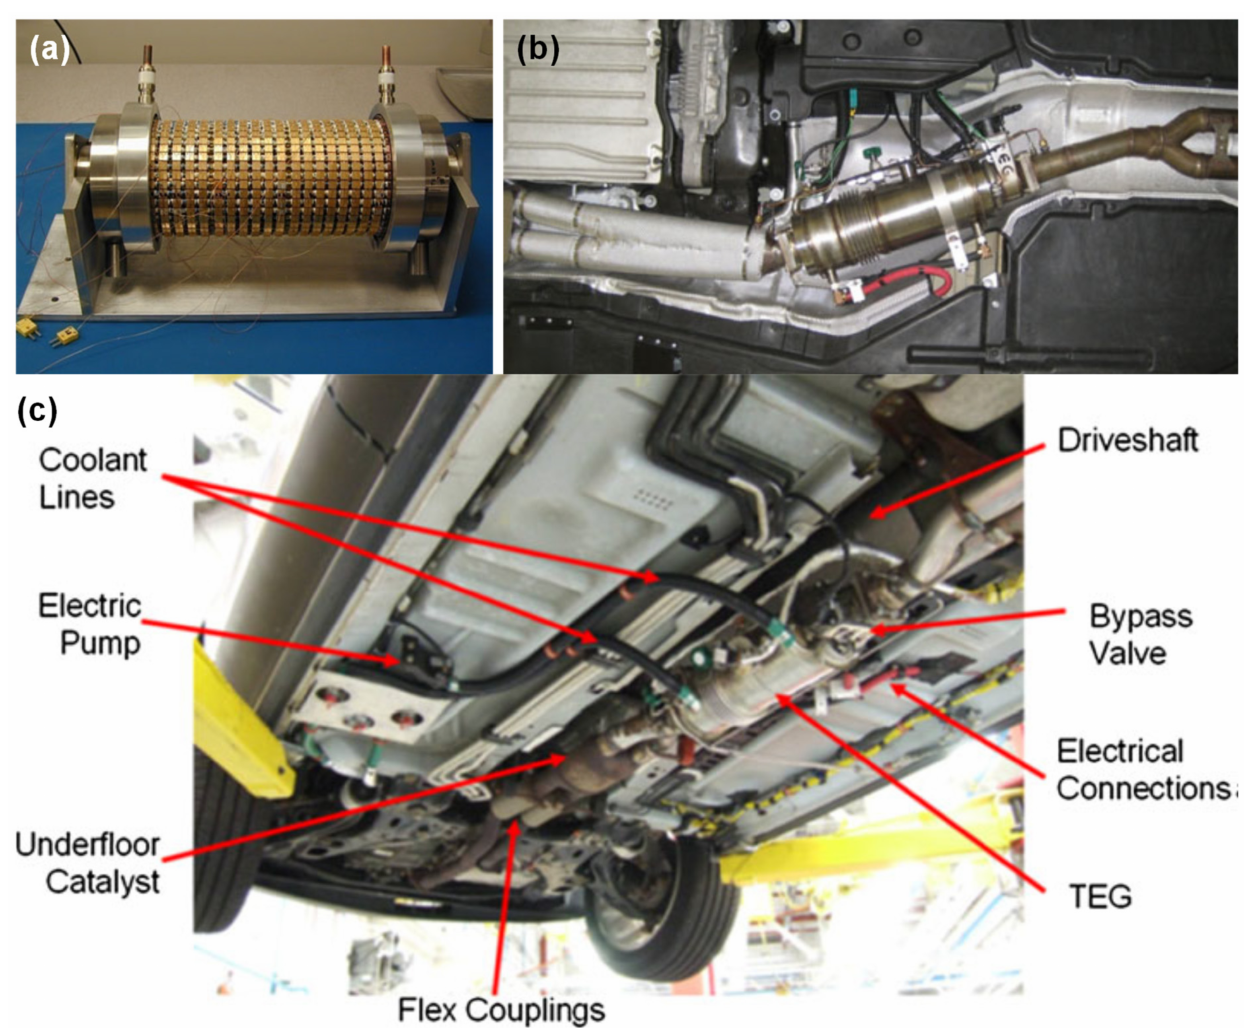
Figure 2. ( a ) Bi 2 Te 3 -based cylindrical TEG device. ( b ) TEG integration into the exhaust line of the BMW X6 prototype vehicle. ( c ) Integration of the TEG into the underfloor of the test vehicle. Figure reproduced with permission from